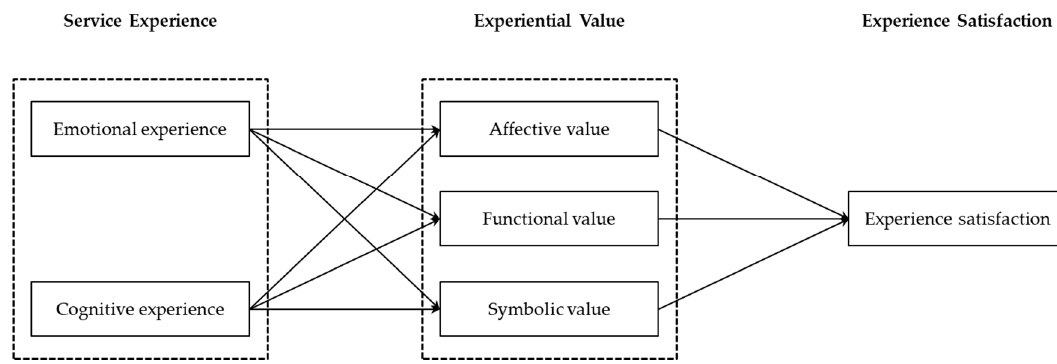
Figure 2. Postpartum home visiting service experience model.